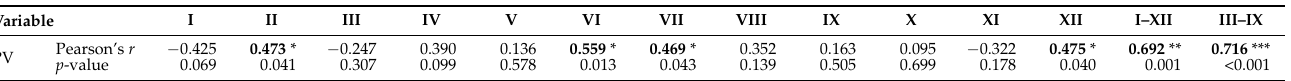
Table 6. Correlations between the rainfall amounts (I–XII) and pastoral value (PV) in ex-arable grassland from Gr ă dinari (period 2003–2021).